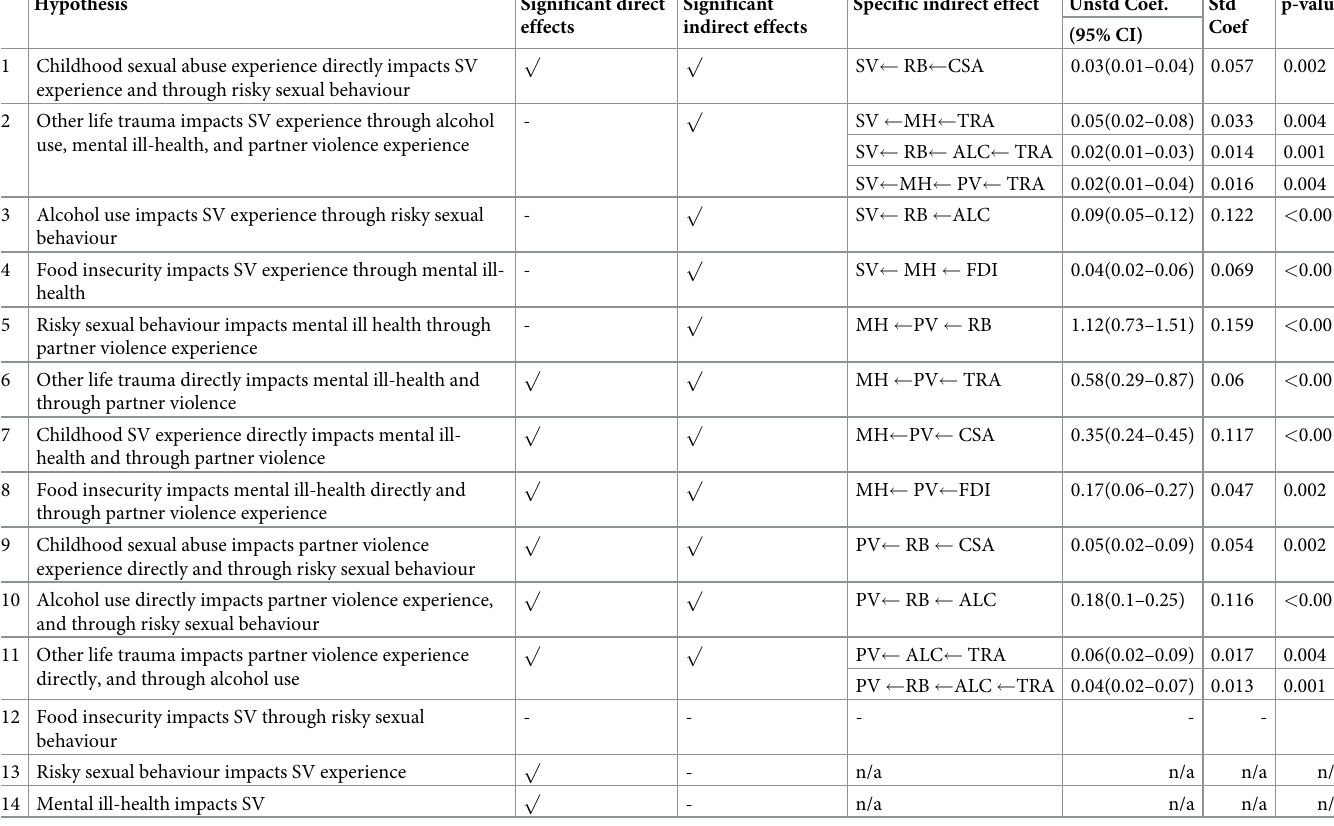
Table 5. Summary comparison of apriori-hypothesis and findings. Female students survey: South African Technical Vocational Education and Training (TVET) col- leges and universities (2018–2019).